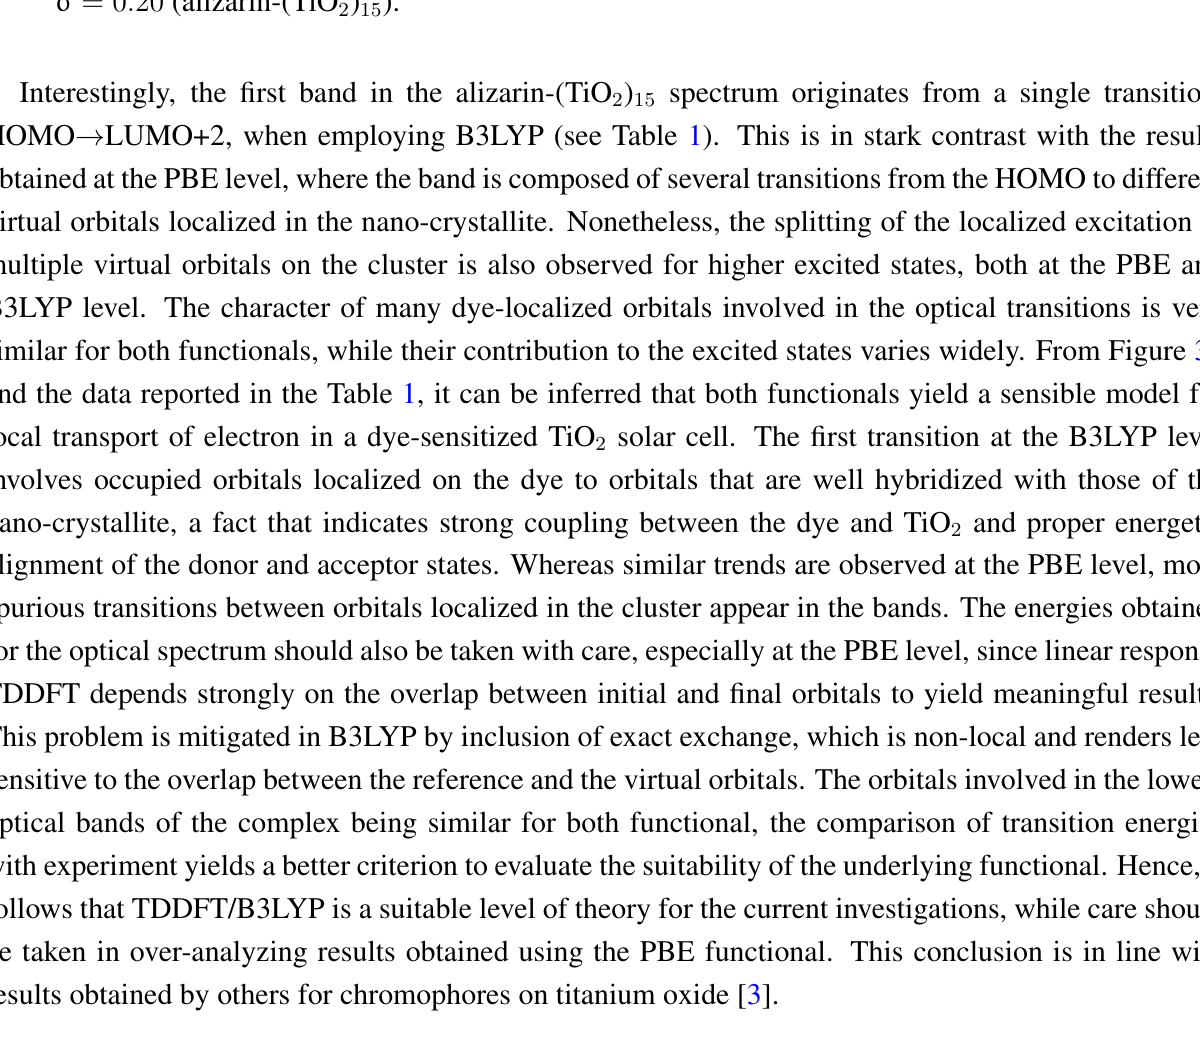
Figure 2. Optical spectra for isolated alizarin and the alizarin-(TiO employing linear response TDDFT and the ( a ) B3LYP and ( b ) PBE functionals. The spectra have been broadened using Lorentzians with width of σ = 0 . 50 (isolated alizarin) and σ = 0 . 20 (alizarin-(TiO ) 2 15